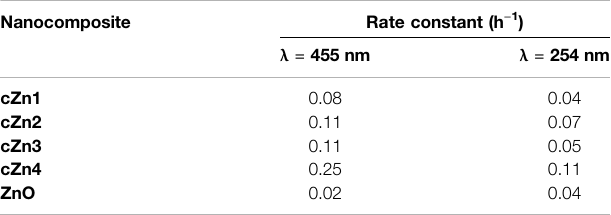
TABLE 2 | Rate constants for photodegradation of rhodamine-B.